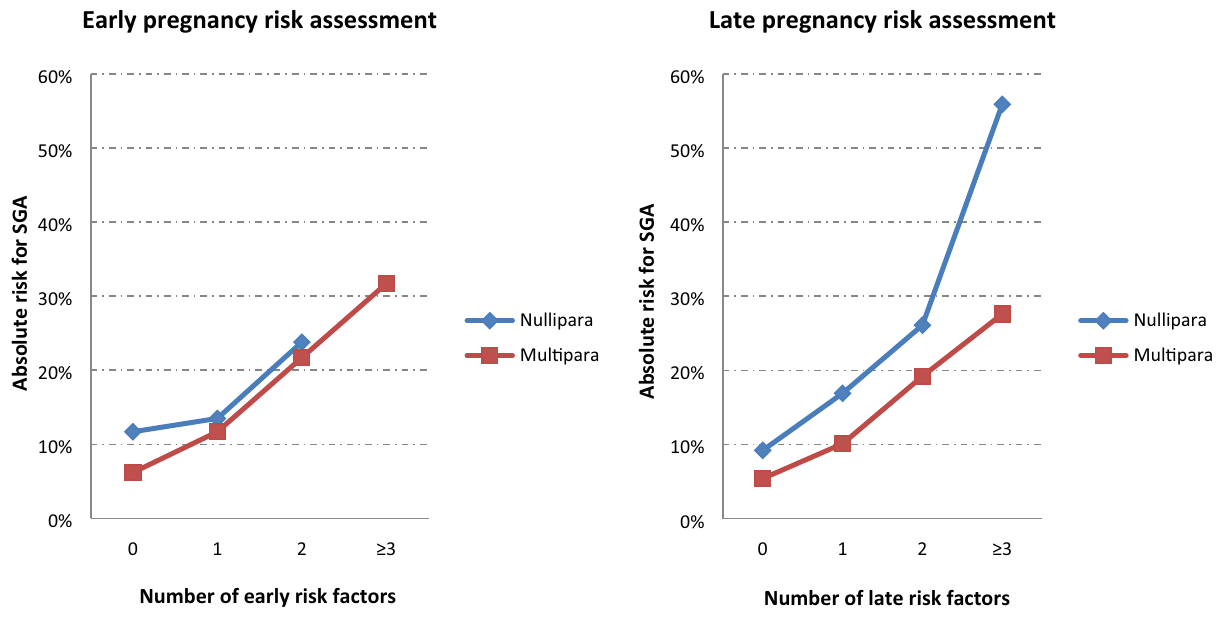
Figure 2. Absolute risks for SGA according to the number of risk factors: early and late pregnancy risk